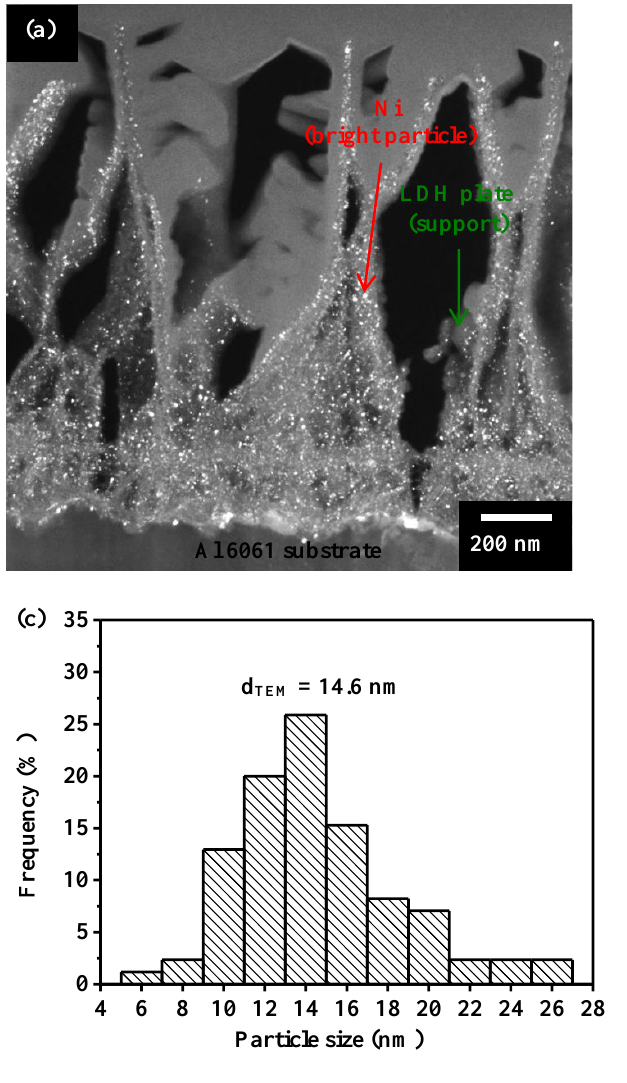
Figure 10. ( a ) TEM cross-sectional microstructure of the NaHCO 3 _T + R catalyst; Particle size distributions of the NaHCO 3 _T + R catalyst ( b ) and NaOH_T + R catalyst ( c ). The particle size distributions in ( b , c ) were collected from the TEM images in Figure S3.